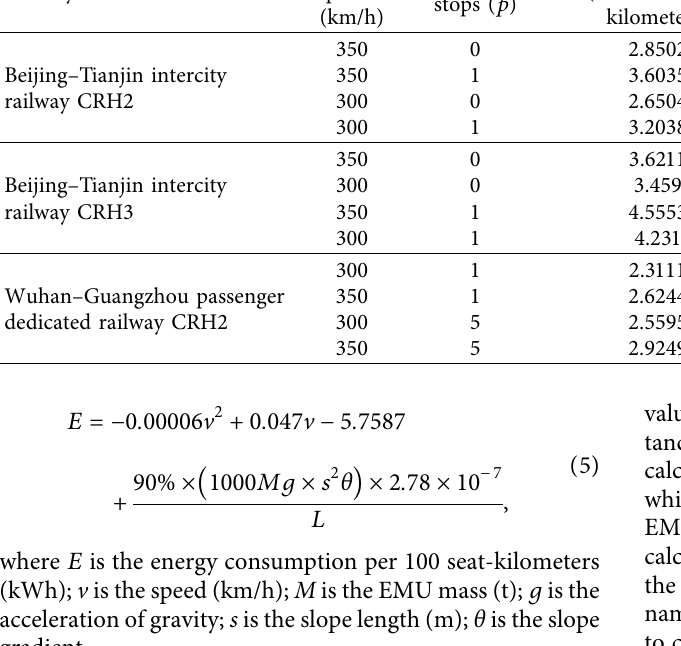
Table 8: Energy consumption with respect to the number of stops for different EMU models on different lines. Railway line and EMC model